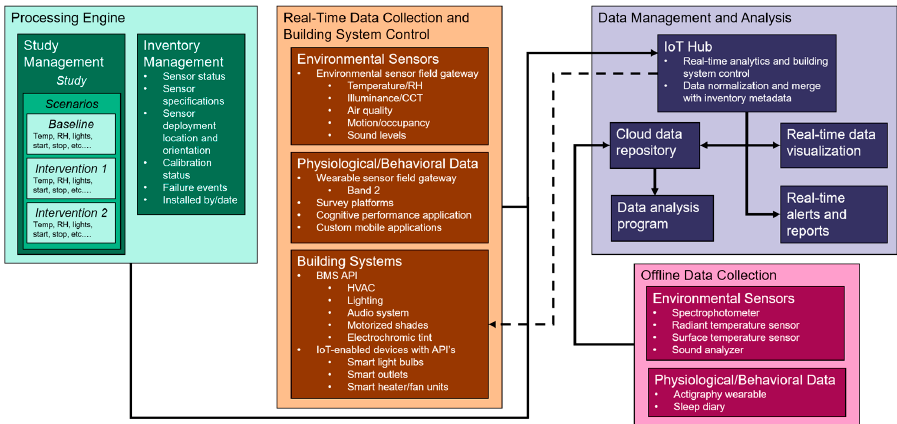
Figure 2. Cloud-based solution for sensor data collection, actuator control, and data management implemented at the Well Living Lab. 358